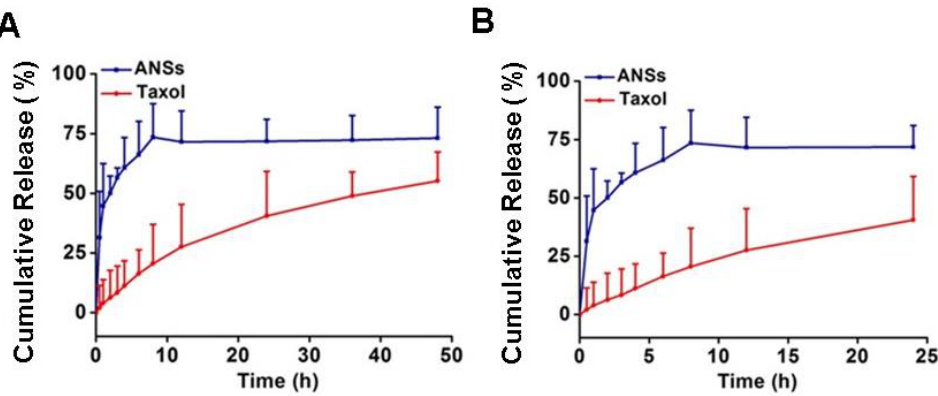
Figure 4. In vitro release profile of PTX from Taxol and ANSs in ( A ) a 48 h duration, and ( B ) in the first 24 h period ( n = 5).